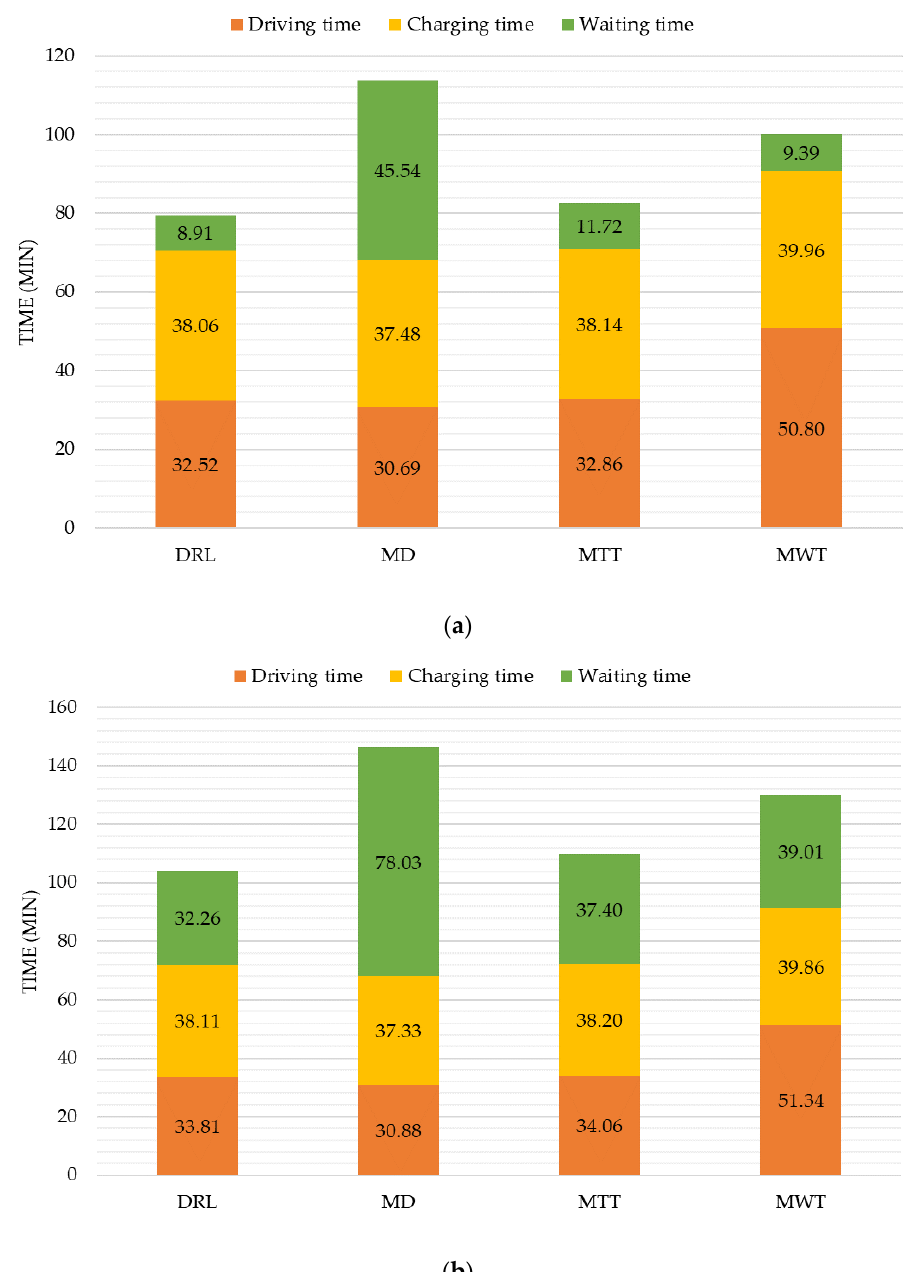
Figure 8. Average travel time of 100 EVs according to distributions: ( a ) Uniform distribution; ( b ) Normal distribution.